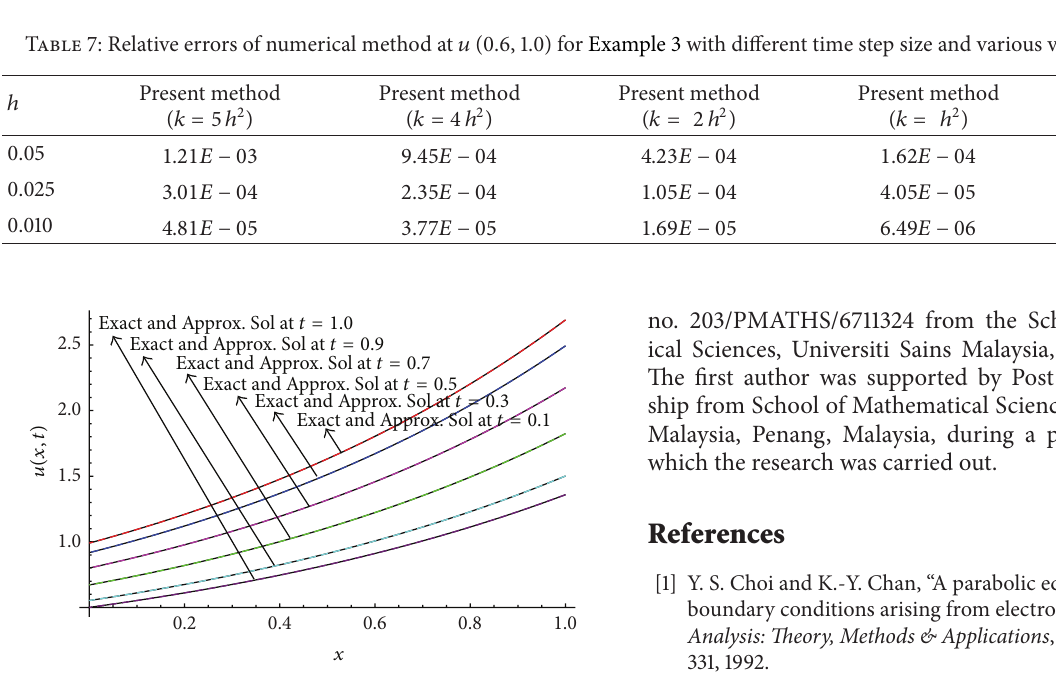
Figure 6: A comparison of numerical solution and known solution at different time levels for Example 3 with ℎ = 0.05 and 𝑘 = 0.01